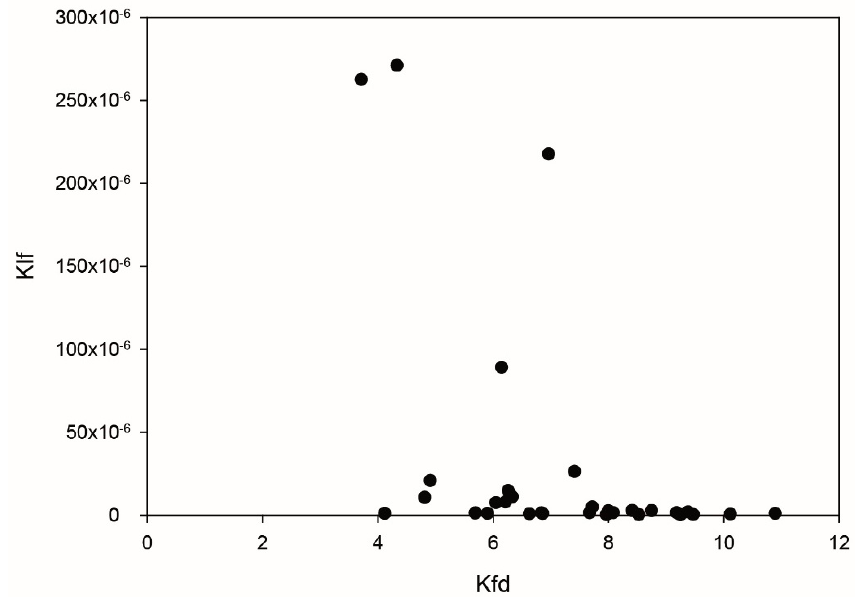
Figure 4. Frequency dependent susceptibility (Kfd) as a function of low-frequency susceptibility (Klf). We used Kfd as defined by [22]; Kfd = 100 × ((Klf − Khf)/Klf). Relatively high values of Kfd (>10%) would suggest the concentration of SP particles. Table 3. Rock magnetic measurements. Sample: Sample name; Type: Rock type; k b : Bulk susceptibility (mass-normalized); k LF and k HF : low-frequency and high-frequency susceptibility, respectively (volume-normalized); MS: Saturation magnetization; M RS : Saturation remanence; B C : Coercivity;